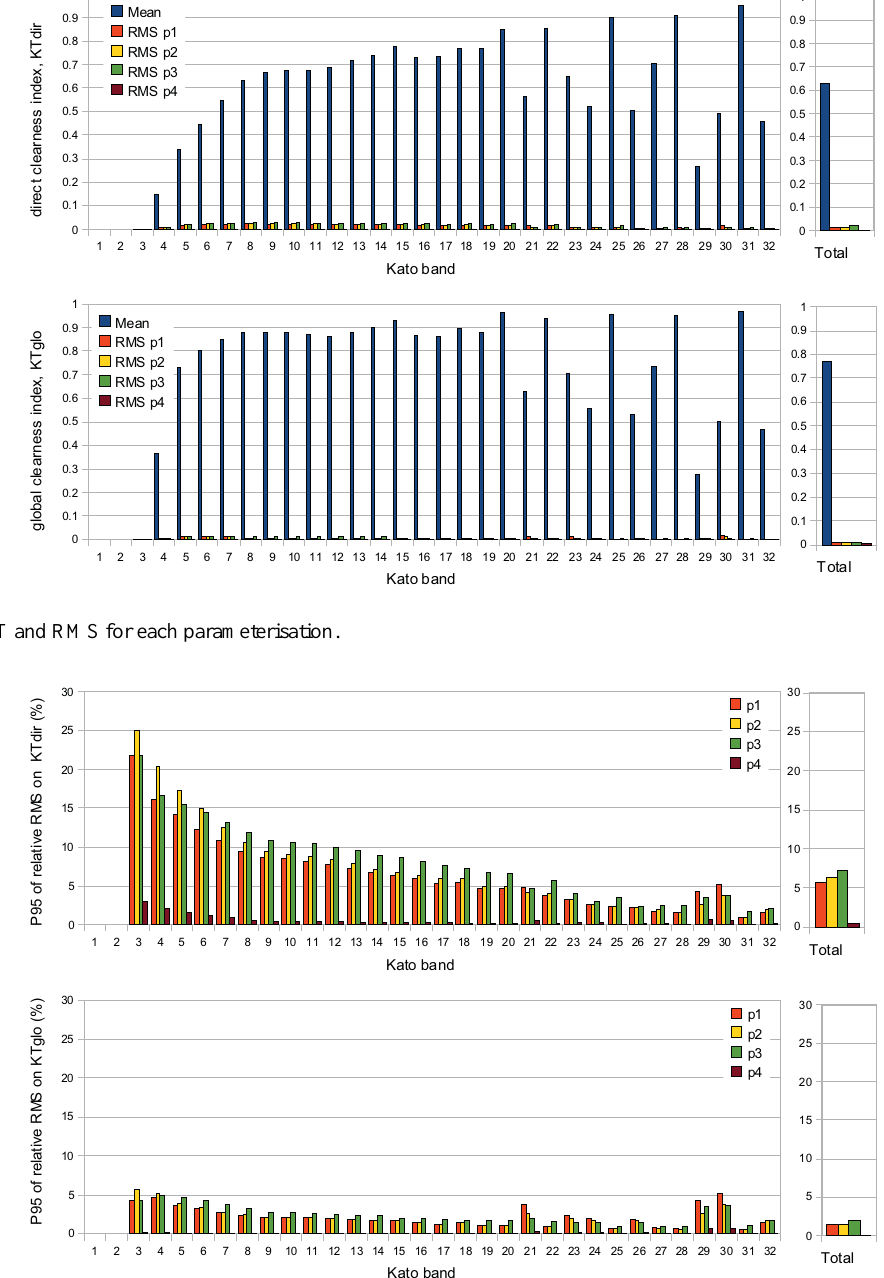
exponent, total column water, total column ozone, altitude of the ground, ground albedo and atmospheric profile. We have selected these optical properties considering their ob- served marginal distribution. More precisely, we have cho- sen the uniform distribution as a model for marginal proba- bility for all parameters except for the parameters related to aerosol, albedo and ozone. We have selected the normal law